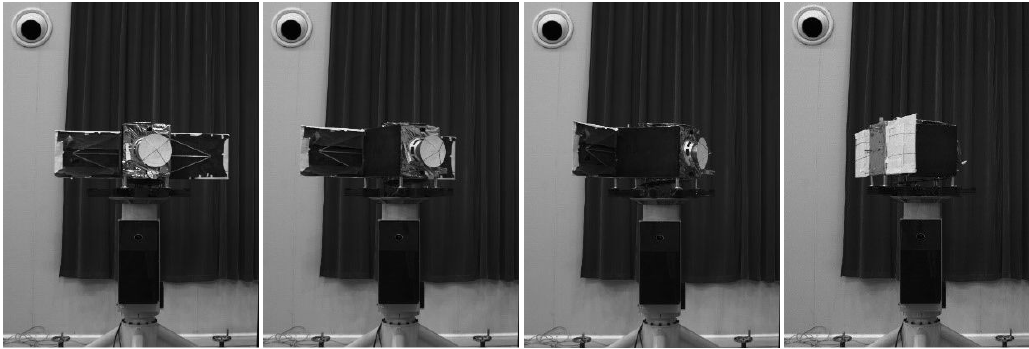
Figure 15. Field experiment.